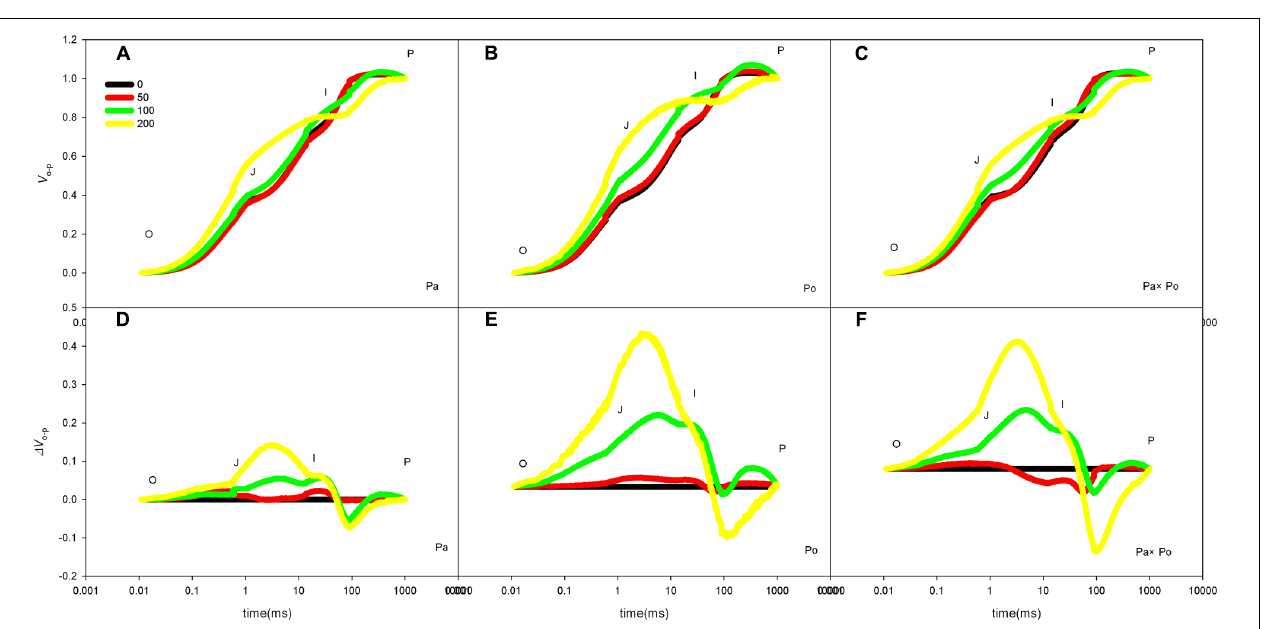
); Po, P. opulifolius “Diabolo” ( ); Pa × Po, P. amurensis Maxim ( ) × P. opulifolius “Diabolo” ( ). ♀ ♂ ♀ ♂